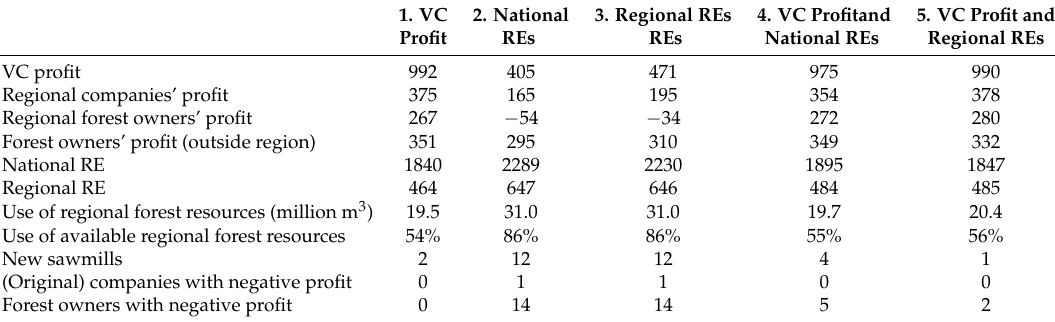
Table 3. Selected model results under five different objectives (all economic values in million